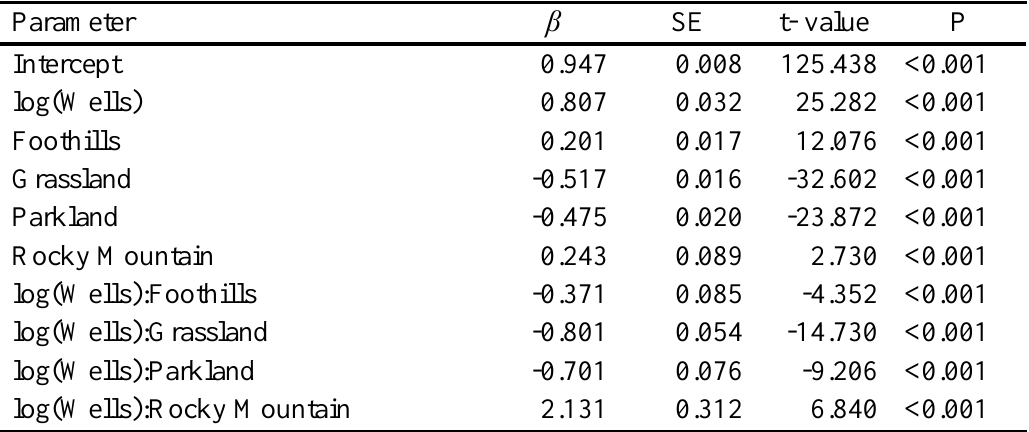
Table A.2.1. Parameter estimates for predicting proportion of townships disturbed by seismic lines. Note: the predictions must by squared due to square root transformation of the response variable prior to analysis.